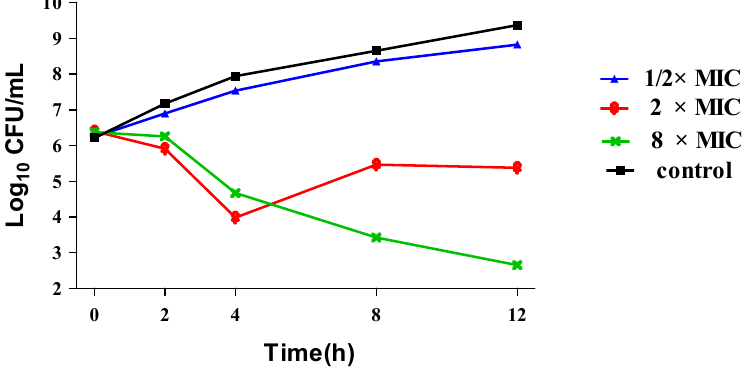
Figure 2. Time-kill curve assay of compound 15a over a 12 h incubation period at 37 °C against MRSA 18-4 (MIC = 0.5 μ g/mL). Samples were taken at 2, 4, 8 and 12 h to determine viable bacterial numbers.